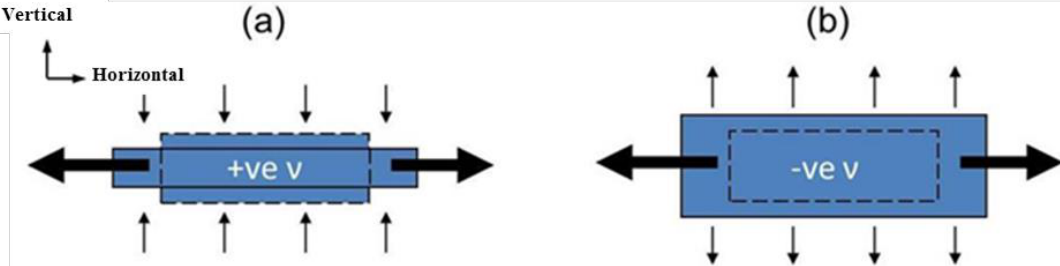
Figure 1. Lateral (vertical) deformation due to Poisson ’ s ratio during tensile axial (horizontal) loading for ( a ) a conventional material and ( b ) an auxetic material. Thick and thin arrows correspond to deformation due to loading and Poisson ’ s ratio respectively.